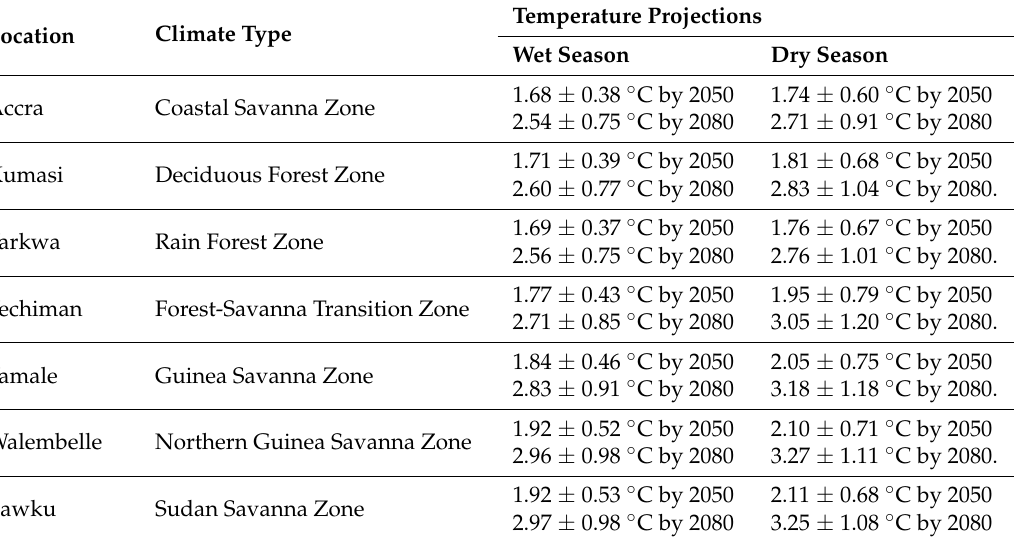
Table 2. Temperature projections in various climate stations in